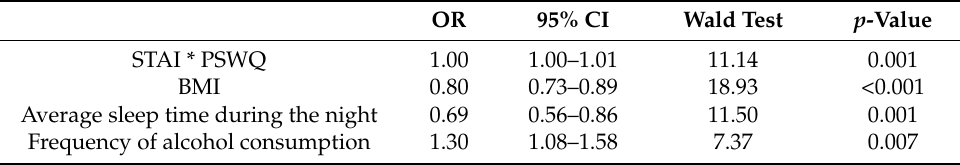
Table 6. Predictors of sleep paralysis in multiple stepwise regression